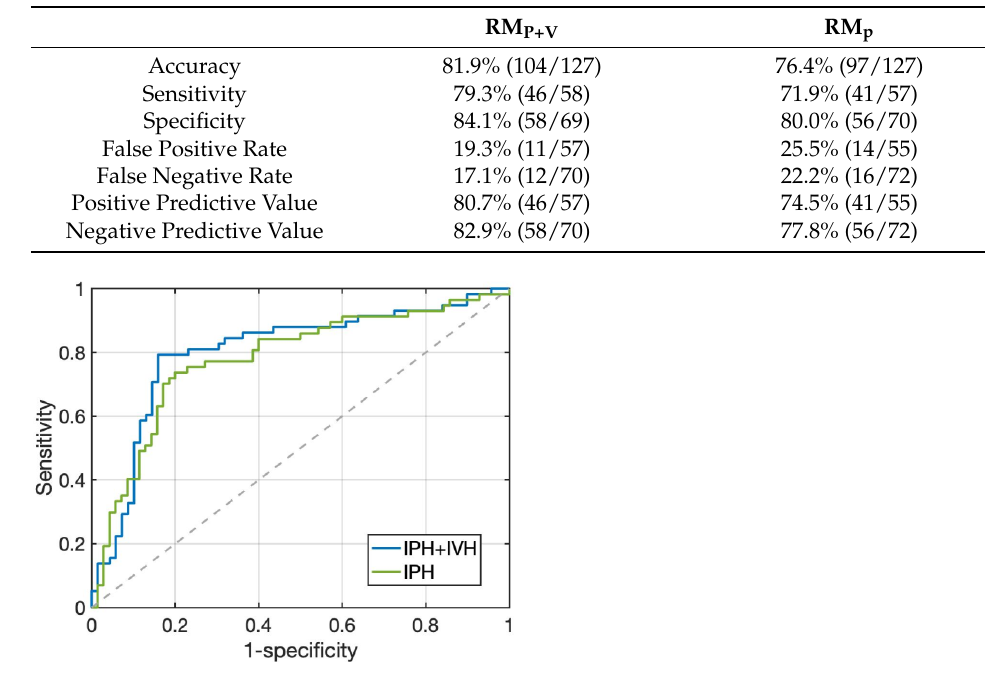
Figure 3. The ROC curves of RM P built using IPH, and RM P+V built using IPH + IVH. The AUC is 0.73 (95% CI: 0.64, 0.80) for RM P , and 0.80 (95% CI: 0.72, 0.87) for RM P+V .